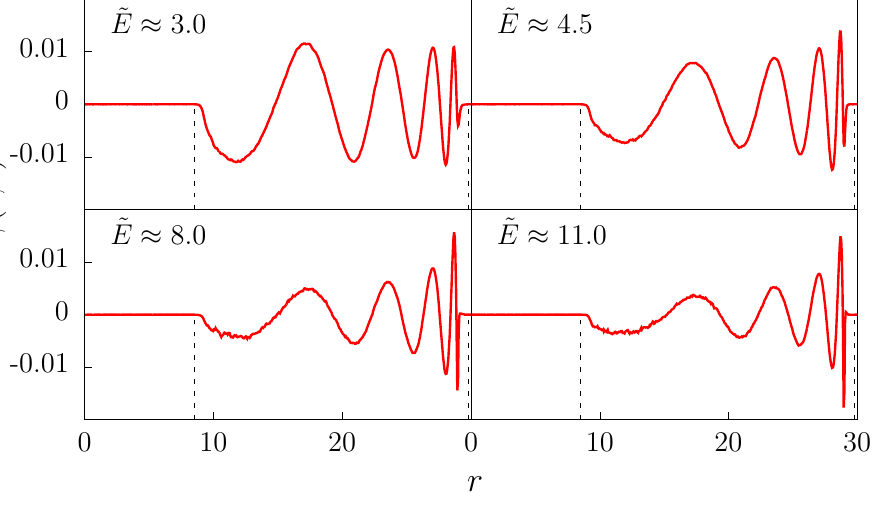
Figure 10 . The same as in (cid:12)gure 7 but for lower boundary